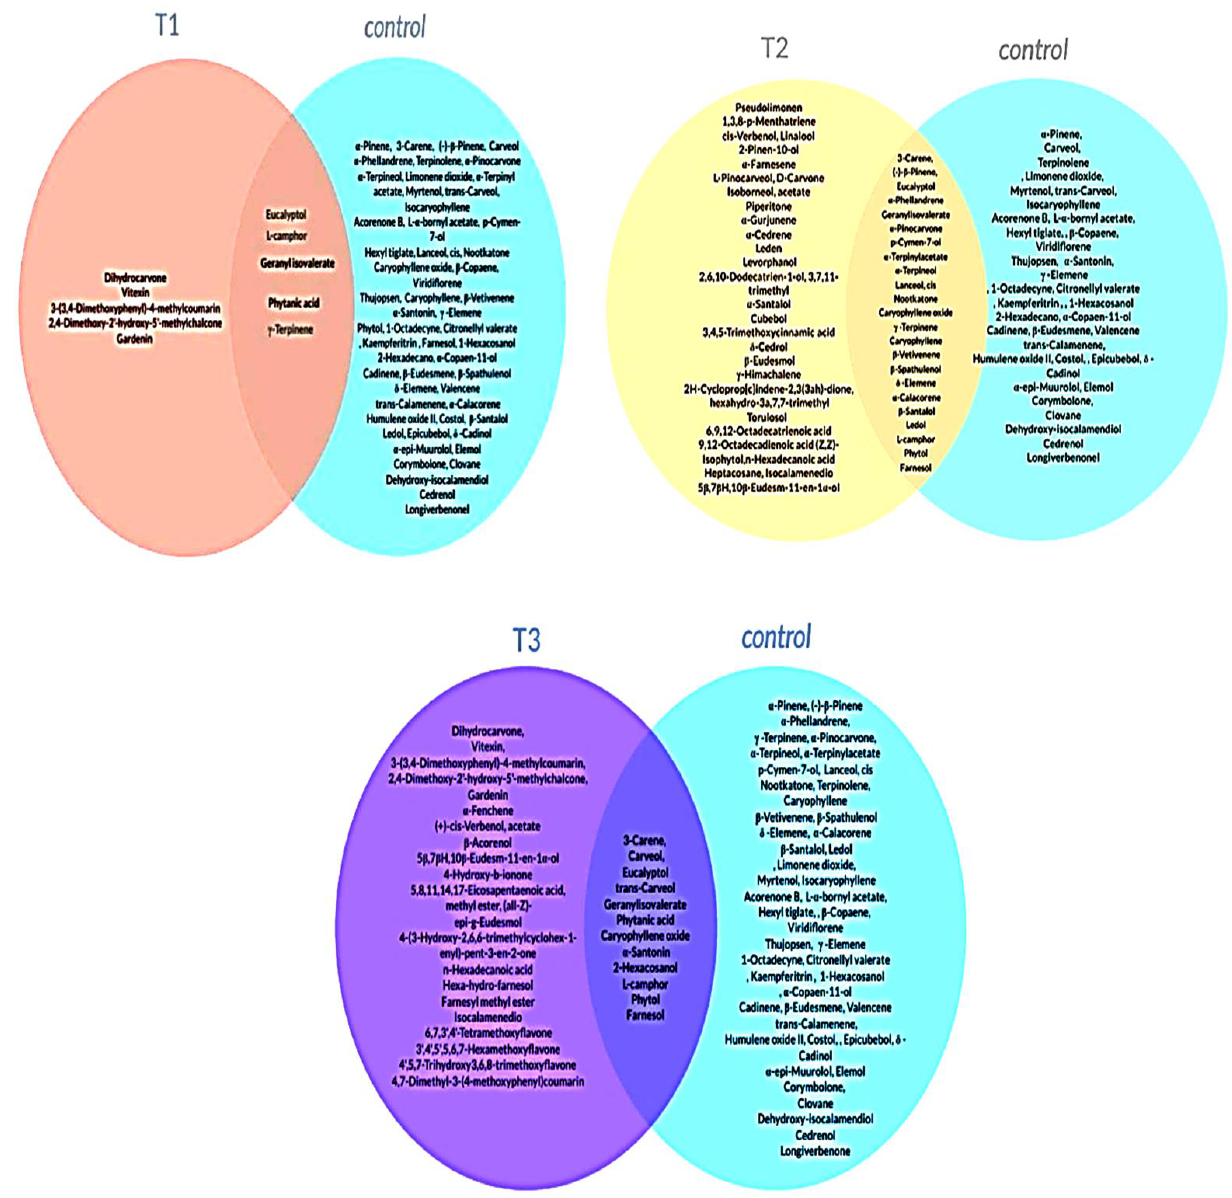
Figure 3. Comparative volatile compositions of essential oil extracted from untreated and treated lavender plants with paclobutrazole; PBZ: ( A ) Venn diagram of volatile compounds of lavender oils extracted from lavender plants, untreated (control) and treated, with PBZ at 200 ppm (T1), ( B ) Venn diagram of volatile compounds of lavender oils extracted from lavender plants, untreated (control) and treated, with PBZ at 400 ppm (T2), and ( C ) Venn diagram of volatile compounds of lavender oils extracted from lavender plants, untreated (control) and treated, with 600 ppm paclobutrazole (T3).